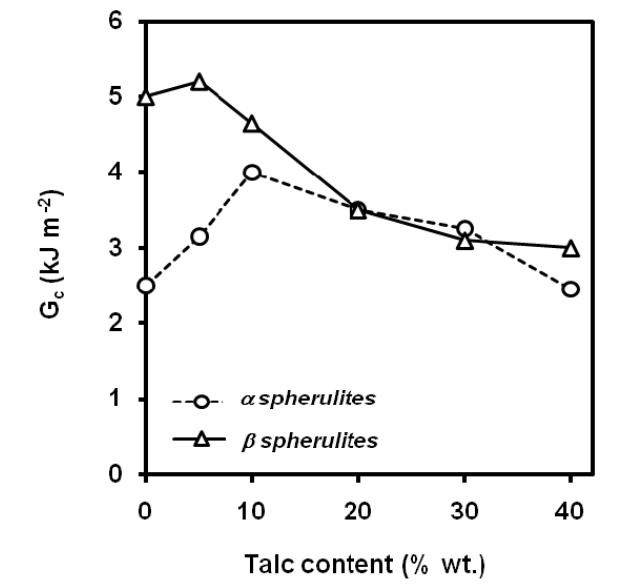
Figure 27. Influence of talc content on the values of G predominant α or β spherulitic crystalline structure (adapted from